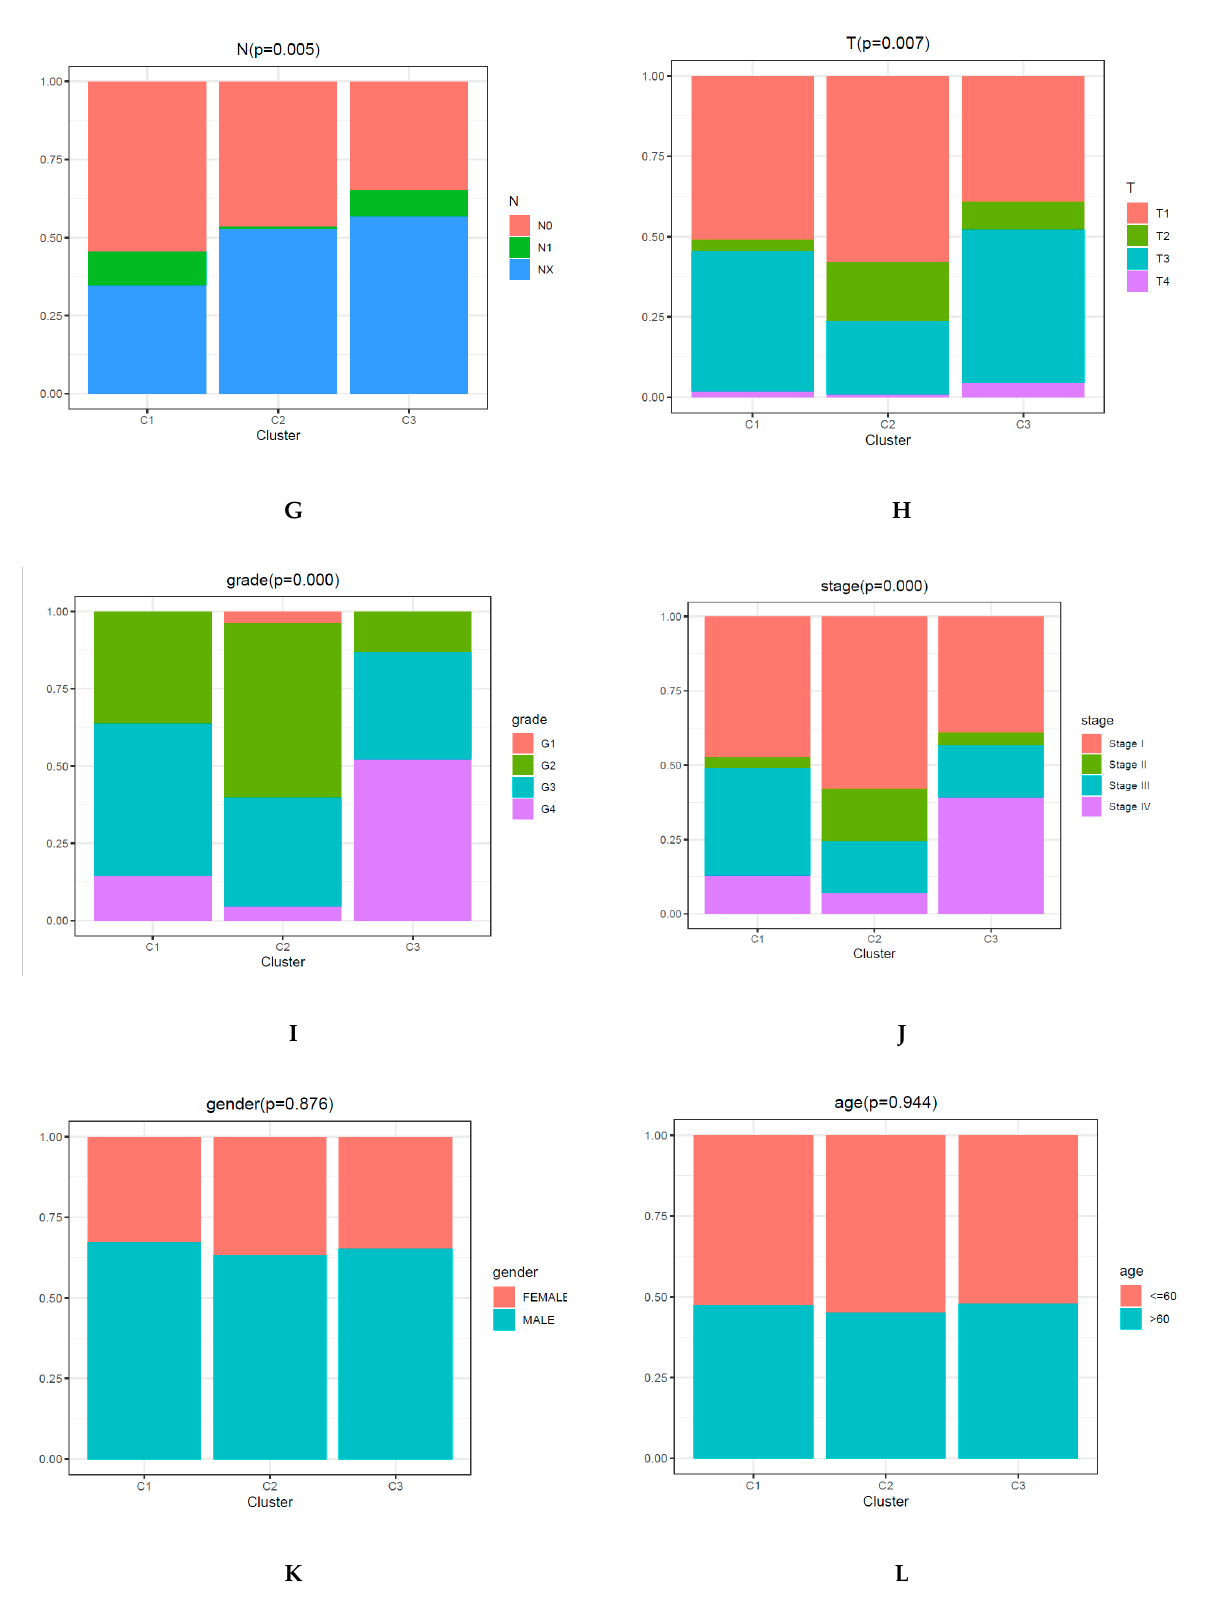
Figure 6. Classification according to CpGs-pair and clinicopathological features in the testing set is consistent with the training set and also different. ( A ) Heatmap of 441 CpGs-pairs. ( B ) PCA validated the stability of the classification. ( C ) Methylation level of each subtype. ( D ) Gene expression level of each subtype. ( E ) Overall survival curve for each DNA CpGs-pair subtype. ( F – L ) Clinicopathological features among each DNA CpGs-pair